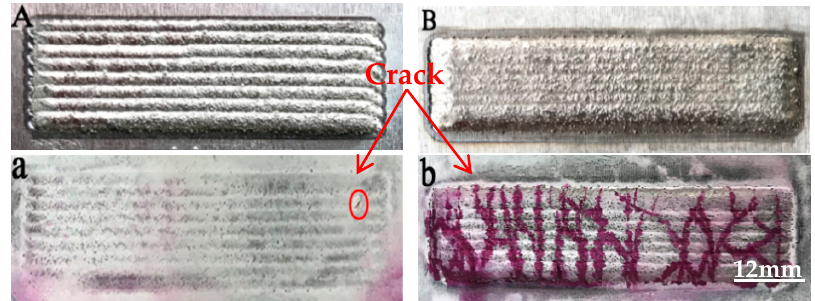
Figure 2. Crack detection results. ( A ) and ( a ) The scheme with the least crack before and after the flaw detection. ( B ) and ( b ) The scheme with the largest crack before and after the flaw detection.